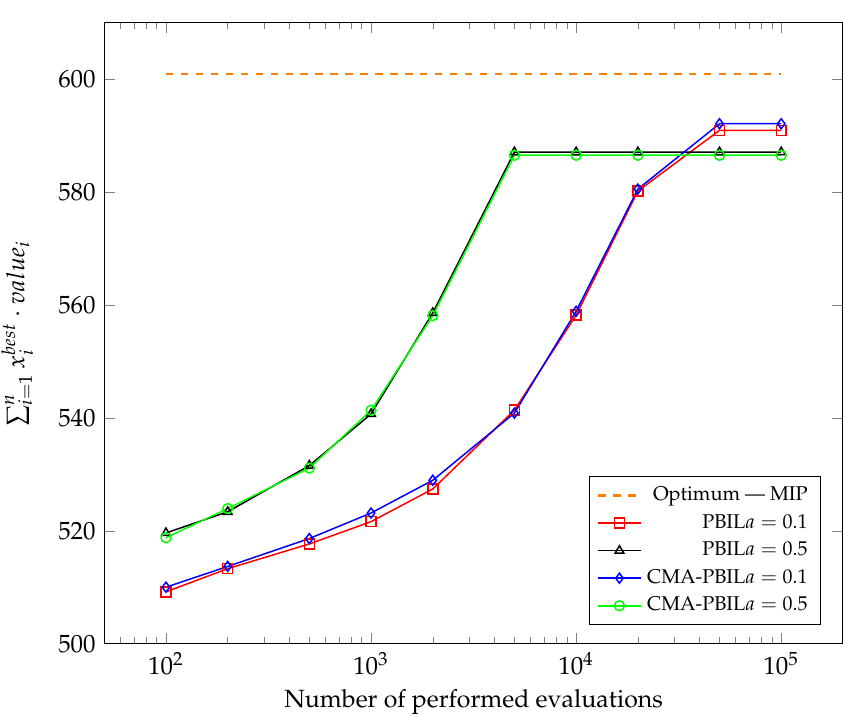
Figure 6. The average of the maximal values of the objective function calculated so far, test case no